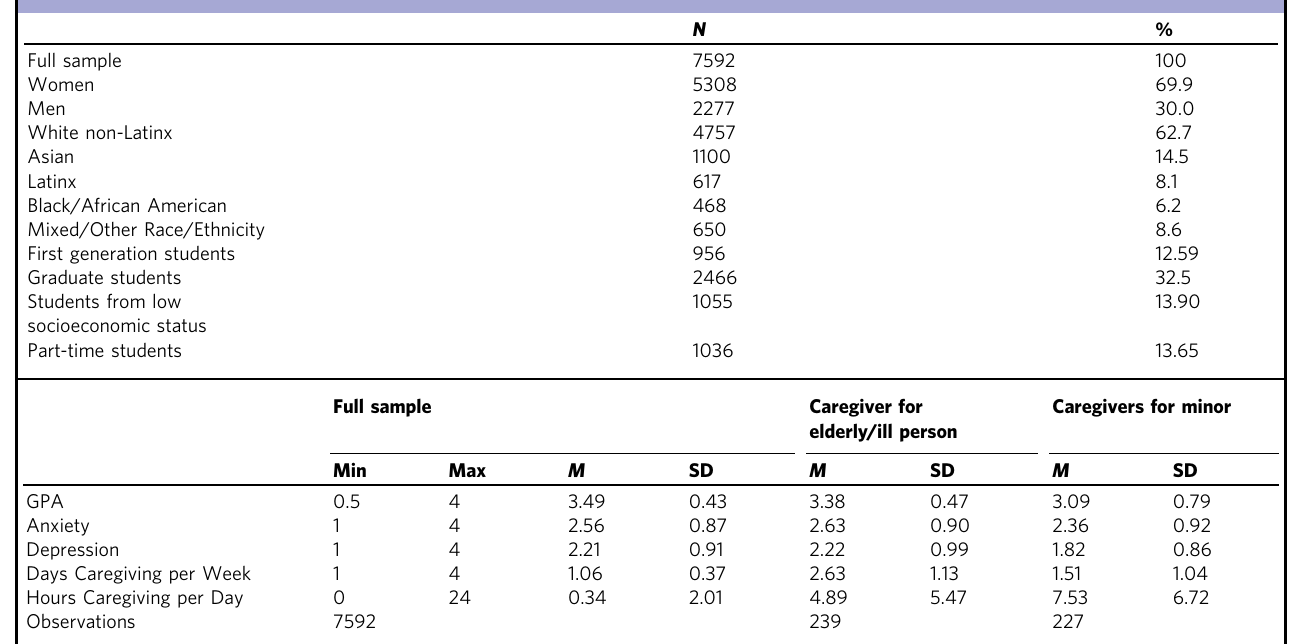
Table 1 Sample demographic statistics and levels of caregiving for the full sample and by caregiver